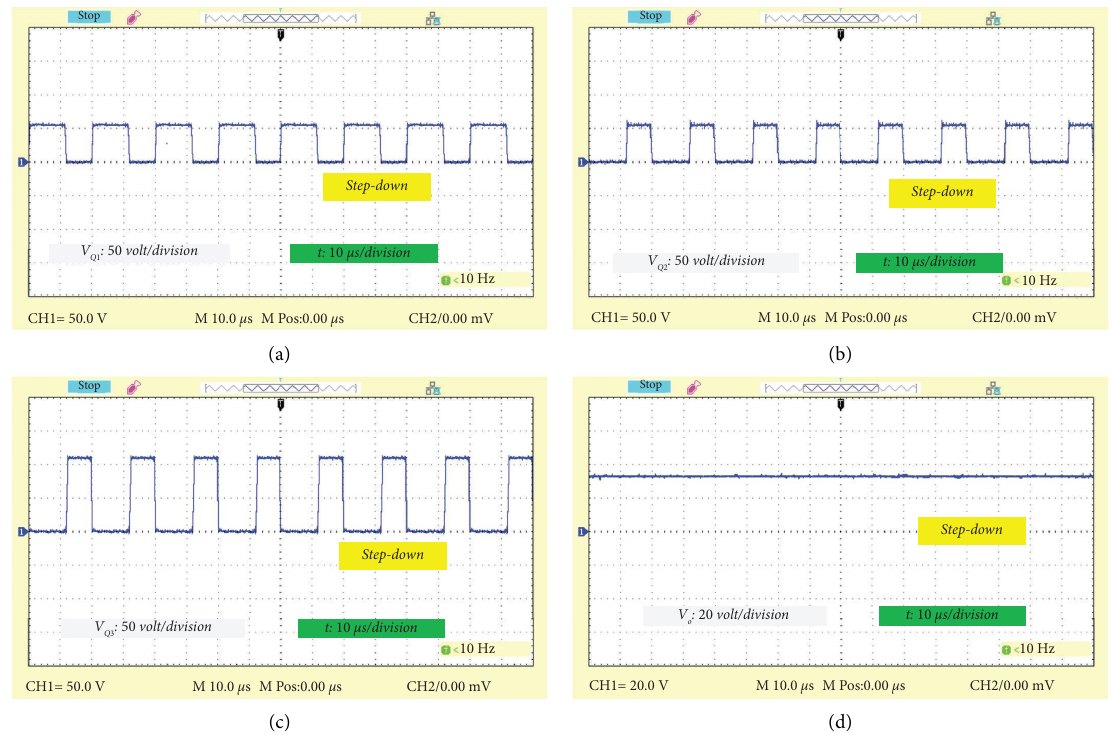
Figure 15: Waveforms in step-down operation: (a) V